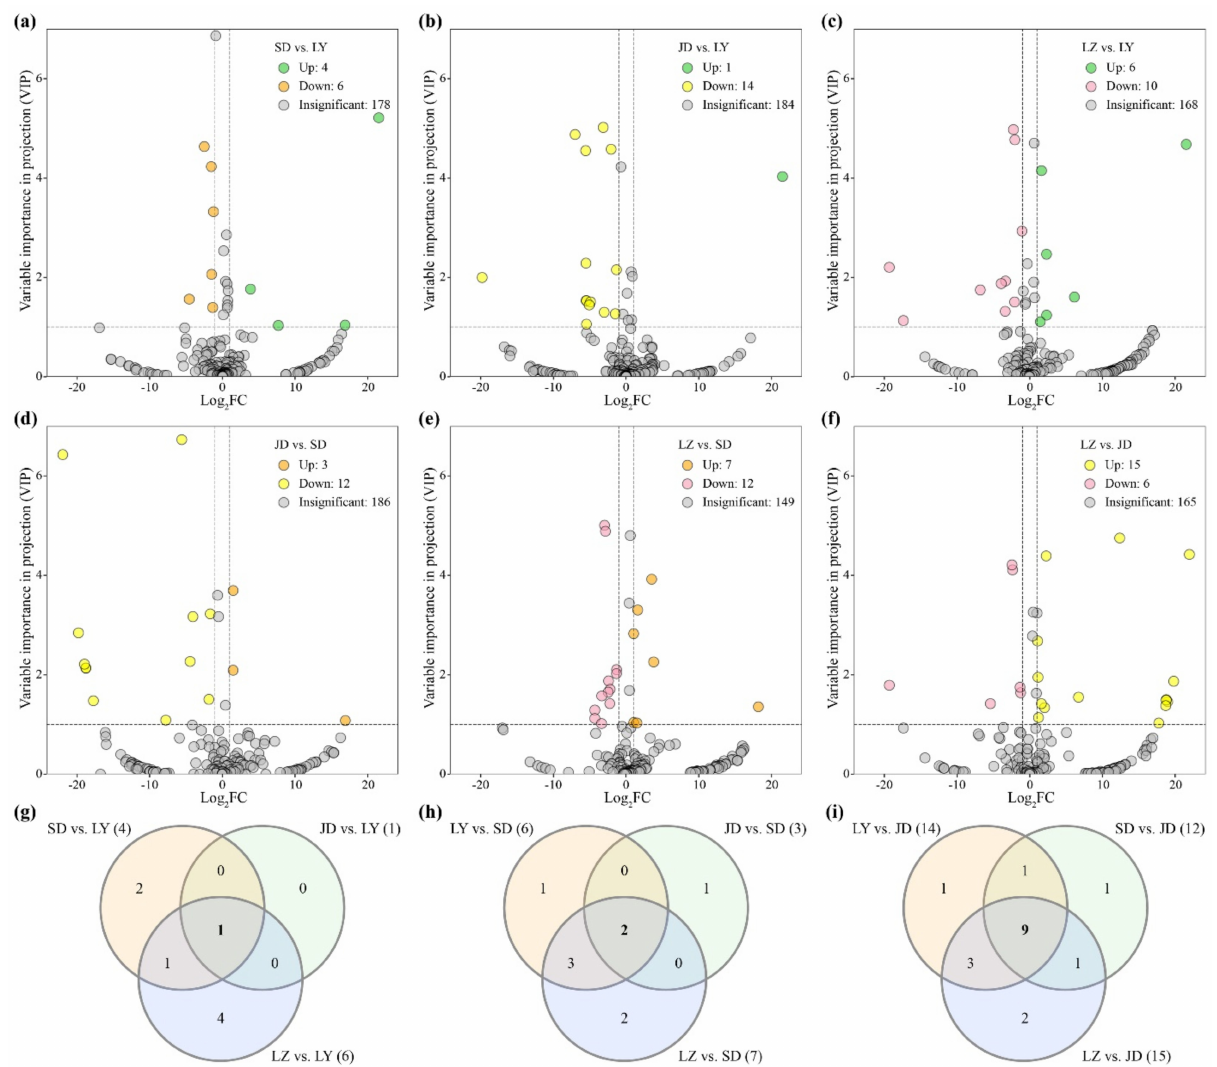
Figure 2. Differential metabolites in four edible Lilium bulbs. Upregulated metabolites are indicated in green ( L. brownii var. viridulum , LY), orange ( L. pumilum, SD), yellow ( L. lancifolium , JD), and pink ( L. davidii var. willmottiae , LZ). ( a ) Volcano plot of the differential metabolites between SD and LY. ( b ) Volcano plot of the differential metabolites between JD and LY. ( c ) Volcano plot of the differential metabolites between LZ and LY. ( d ) Volcano plot of the differential metabolites between JD and SD. ( e ) Volcano plot of the differential metabolites between LZ and SD. ( f ) Volcano plot of the differential metabolites between LZ and JD. ( g ) Venn plot indicating the number (in bold) of commonly upregulated metabolites among the comparison groups of SD vs. LY, JD vs. LY, and LZ vs. LY. ( h ) Venn plot indicating the number (in bold) of commonly upregulated metabolites among the comparison groups of LY vs. SD, JD vs. SD, and LZ vs. SD. ( i ) Venn plot indicating the number (in bold) of commonly upregulated metabolites among the comparison groups of SD vs. LY, JD vs. LY, and LZ vs.